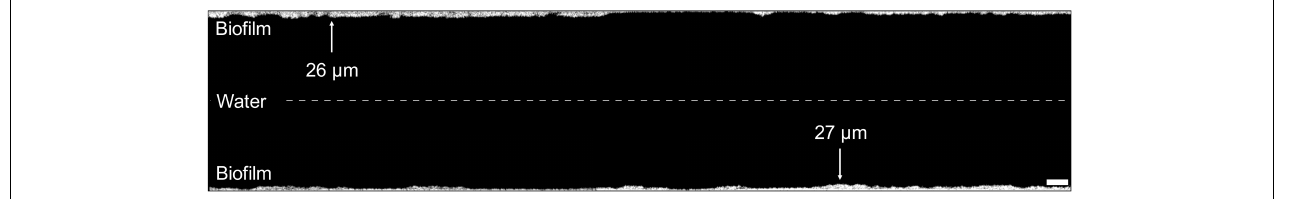
FIGURE 4 | Visualization of the real hose biofilm imaged with optical coherence tomography. Images (2 mm length) were combined to illustrate the biofilm structure and thickness of a mm section, showing a representative example of the shower hose biofilm. Distance between top and bottom sections is not to scale. Scale bar: 200 µ